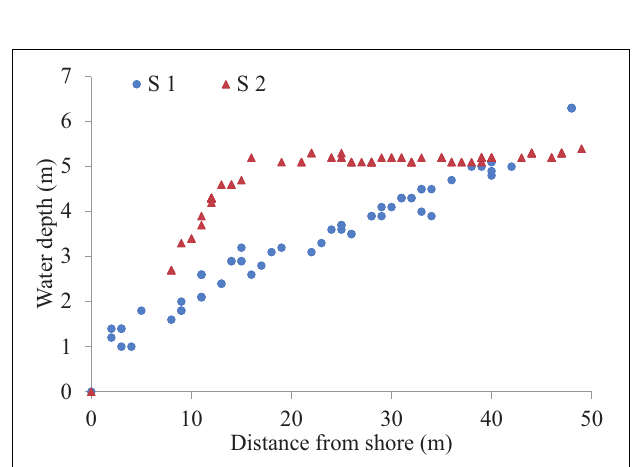
FIGURE 2 | Water depth by distance from shore at each site (data collected on SCUBA at high tide, February 28, 2017).